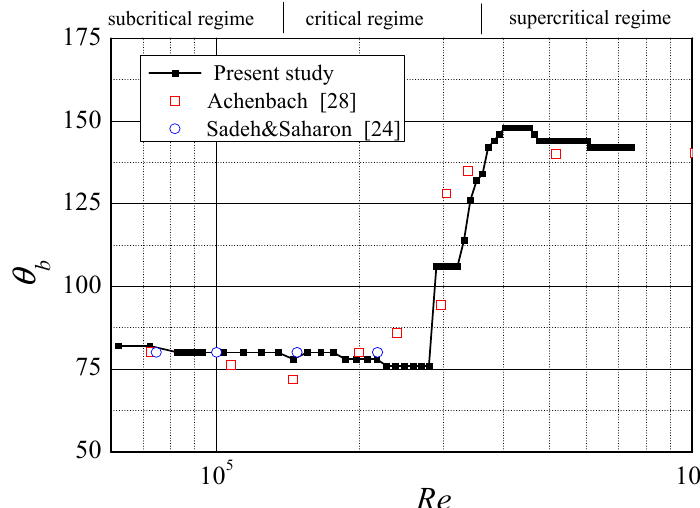
Figure 5 . The angular position of where the base region starts θ b in the smooth flow.